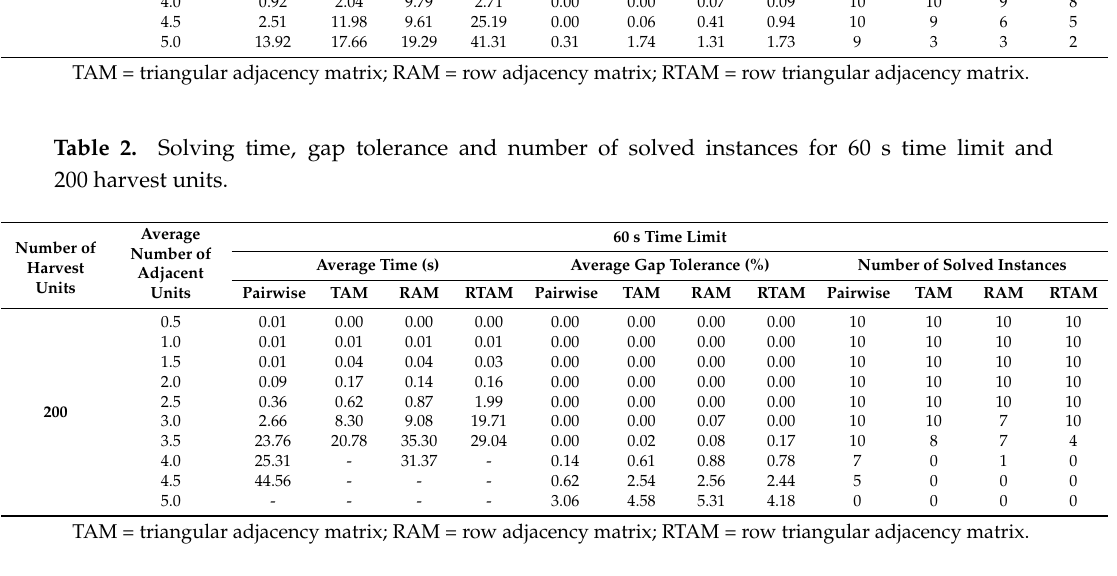
Table 3. Solving time, gap tolerance and number of solved instances for 60 s time limit and 300 harvest